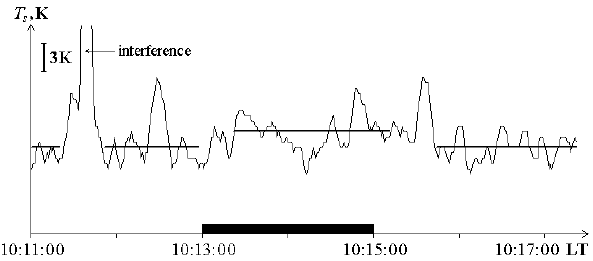
Fig. 3. The same as in Fig. 2, but for 27 September 1998. f = 598MHz, f 0 = 5 . 455MHz, β = 60 ◦